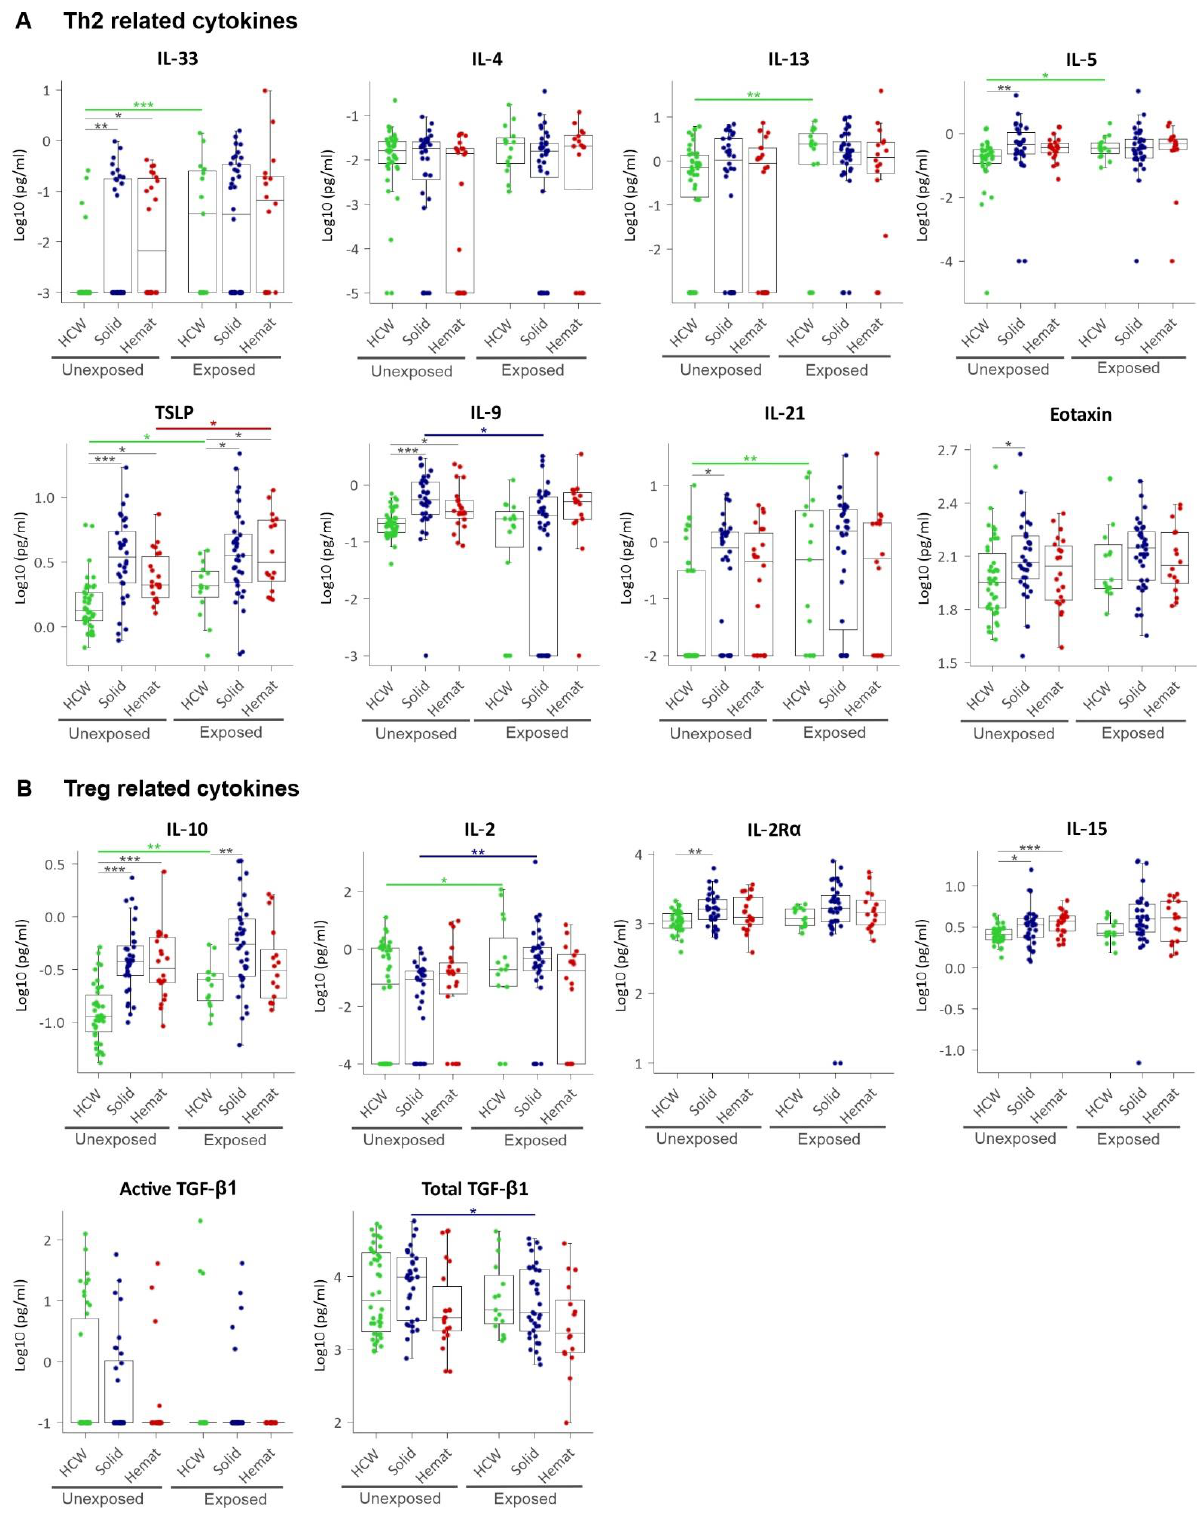
Figure 4. Plasma levels of ( A ) Th2 related (anti-inflammatory) cytokines and ( B ) Treg-related (immunomodulatory) cytokines. HCW, health care workers (green); solid, patients with solid tumours (blue); hemat, patients with haematological malignancies (red). Each dot represents the sample closest to exposure in the case of exposed patients, and an average of multiple timepoints, when available, for unexposed patients. * p < 0.05, ** p < 0.01, *** p <